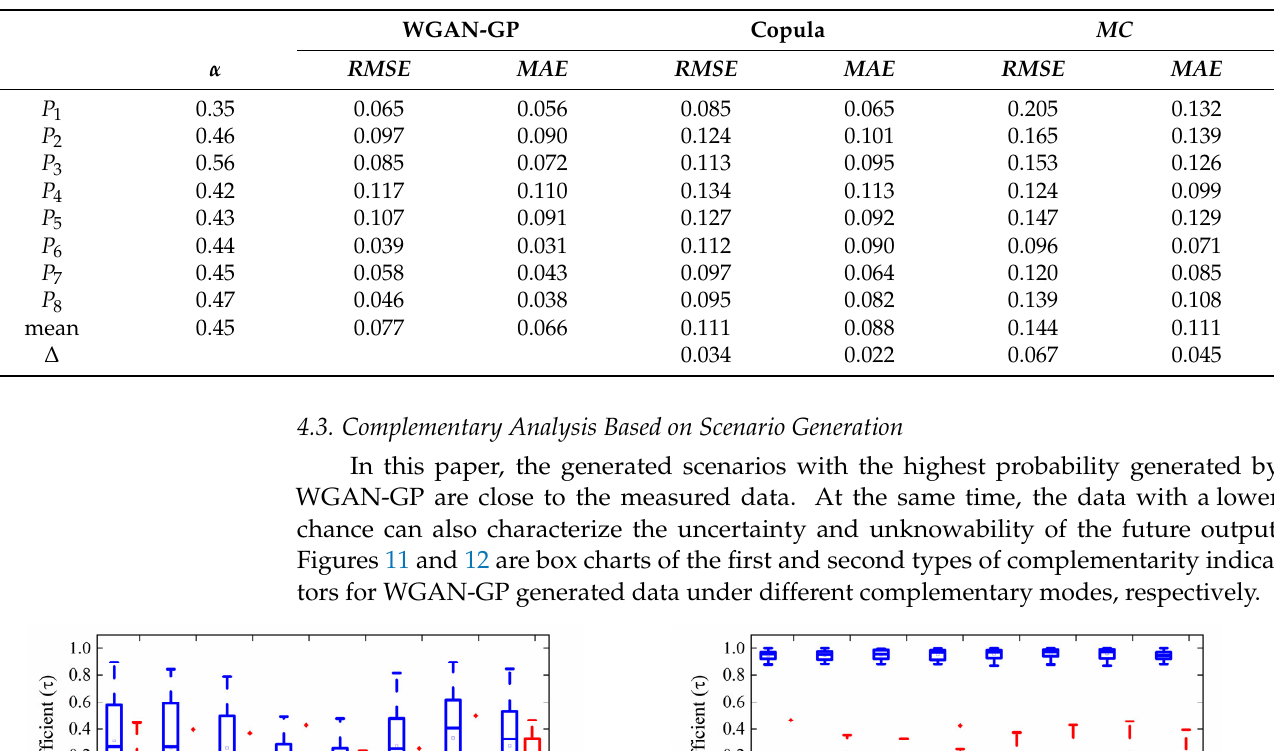
Table 6. The error of the hybrid system with generated data.